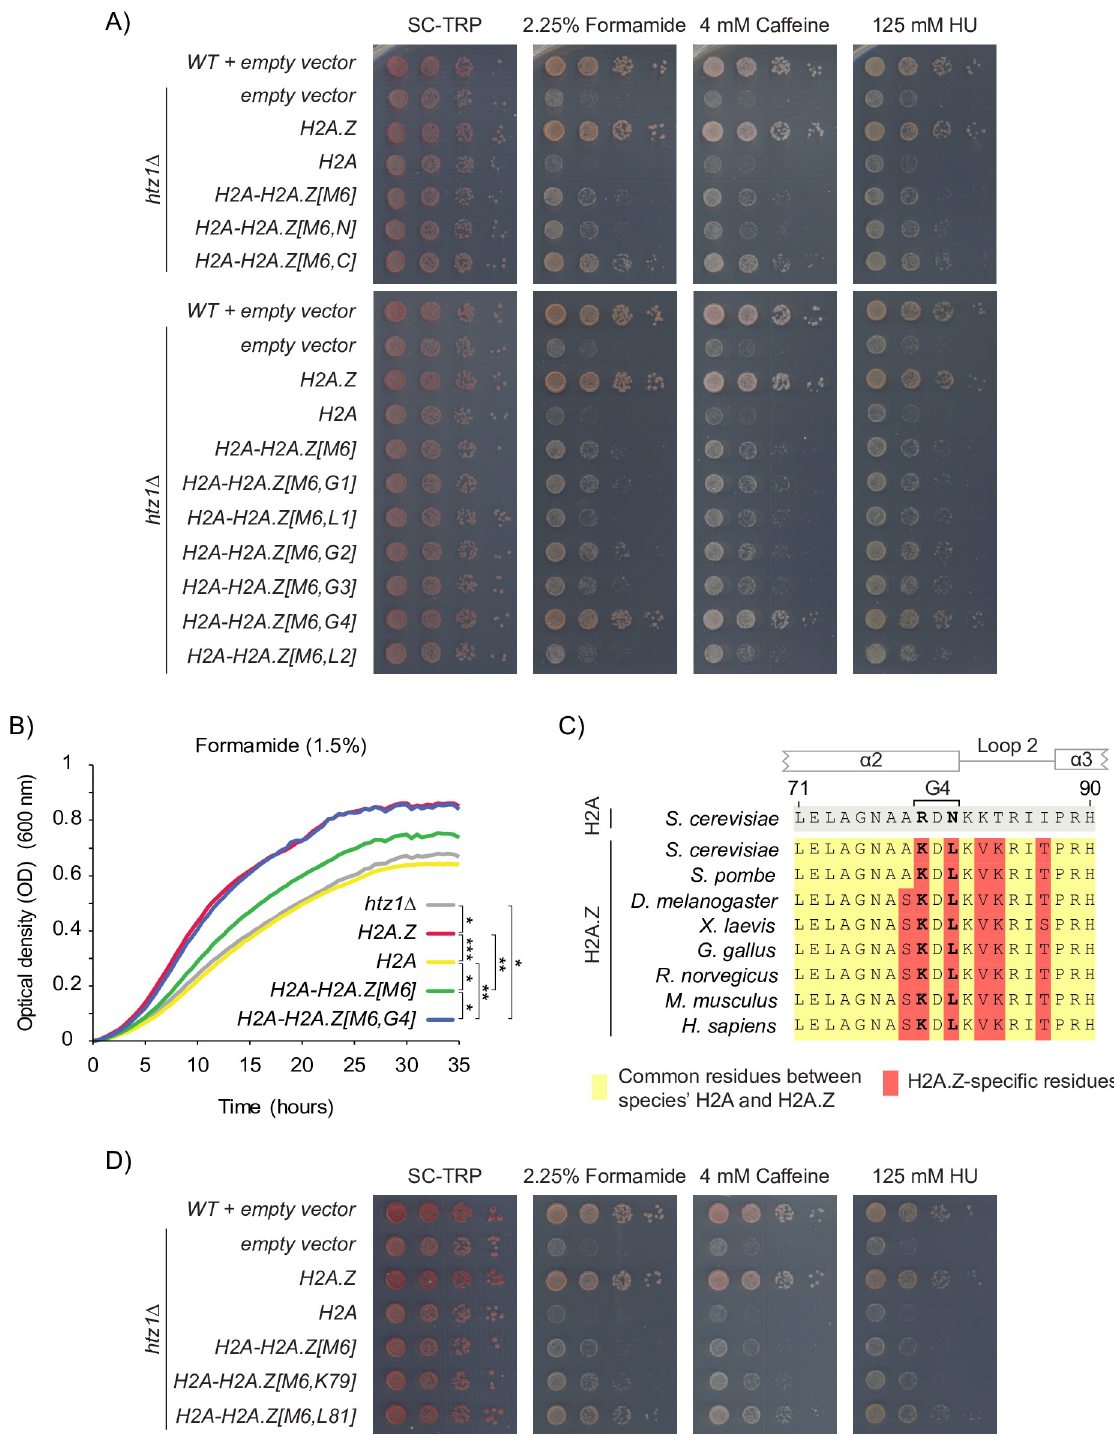
Fig 4. In combination with M6, an evolutionary conserved region in the alpha 2 helix of H2A.Z distinguished the histone variant H2A. Z from replicative H2A and conferred H2A.Z-specific growth phenotypes. (A) The H2A-H2A . Z[M6 , G4] mutant had comparable growth to the H2A . Z mutant. Cells expressing the indicated hybrid constructs were 10-fold serially diluted, spotted onto SC-TRP media with the indicated concentrations of formamide, caffeine, and hydroxyurea and grown for 3 days. (B) The growth curves of the H2A . Z and H2A-H2A . Z[M6 , G4] mutants were indistinguishable. Each curve was generated by taking the average OD (measured every 20 minutes) of three biological replicates grown in SC-TRP liquid media in the presence of 1.5% formamide. Asterisks indicate significant comparisons